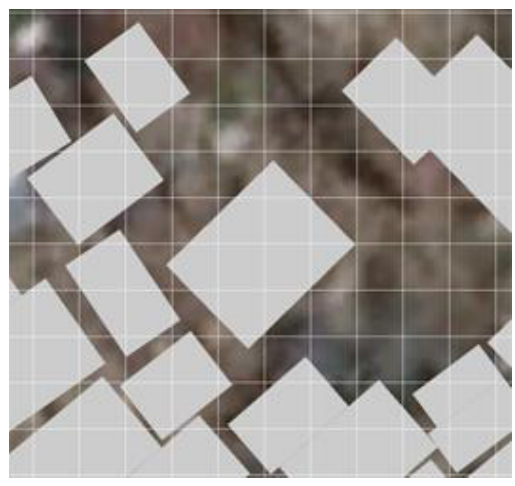
Figure 3: Grid overlaid on top of